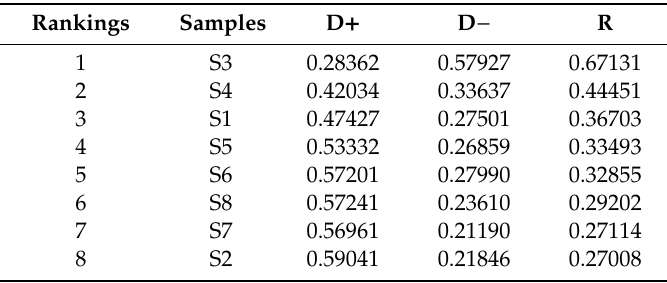
Table 6. Final rankings by the TOPSIS approach.